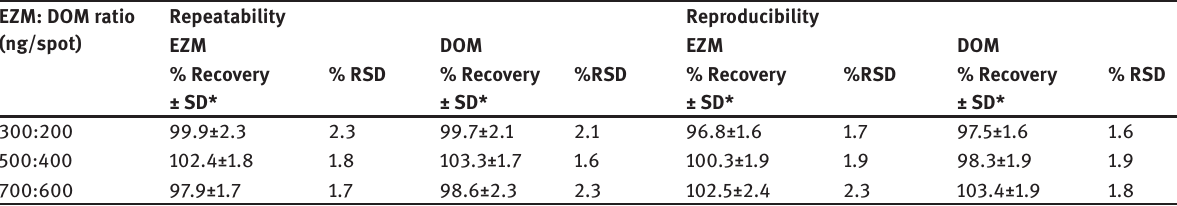
Table 2: Repeatability and reproducibility.